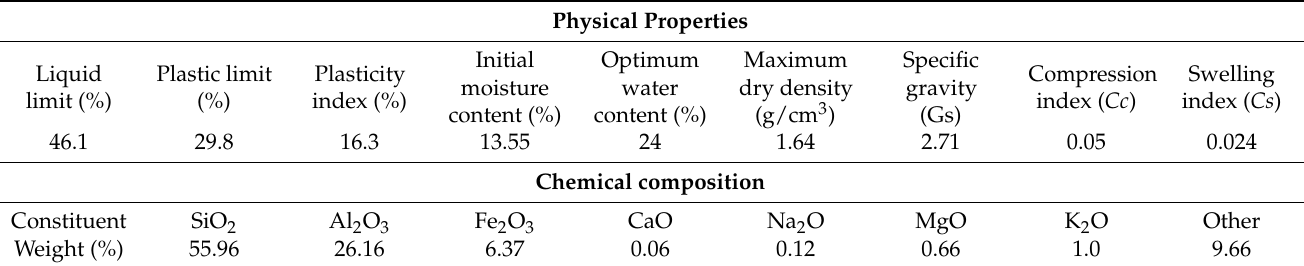
Table 1. Physical properties and chemical composition of red